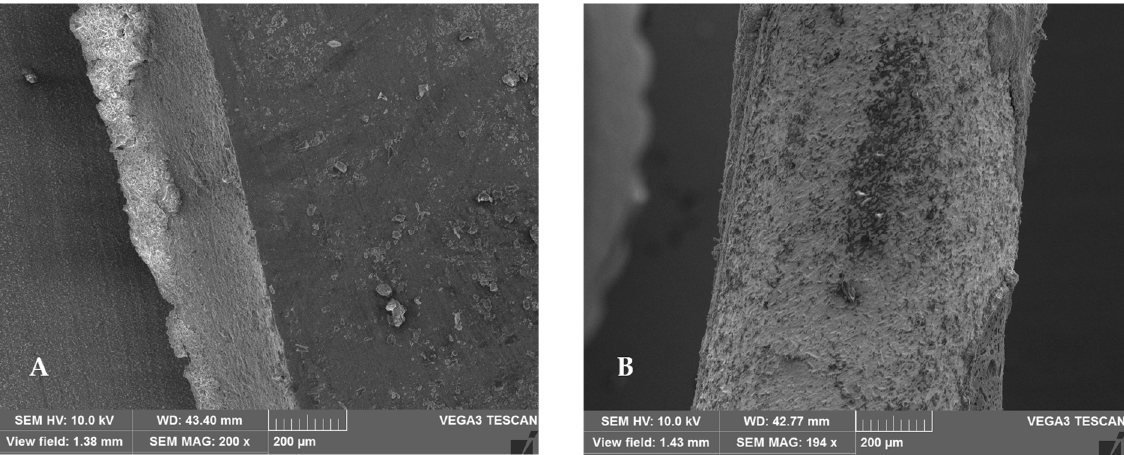
Figure 9. Scanning-electron-microscope image of ( A ) Sectioned root canal, and ( B ) displaced post, at 200× magnification, showing cohesive failure mode in Group 1 (CCNPPCs) sample at root/post interface.